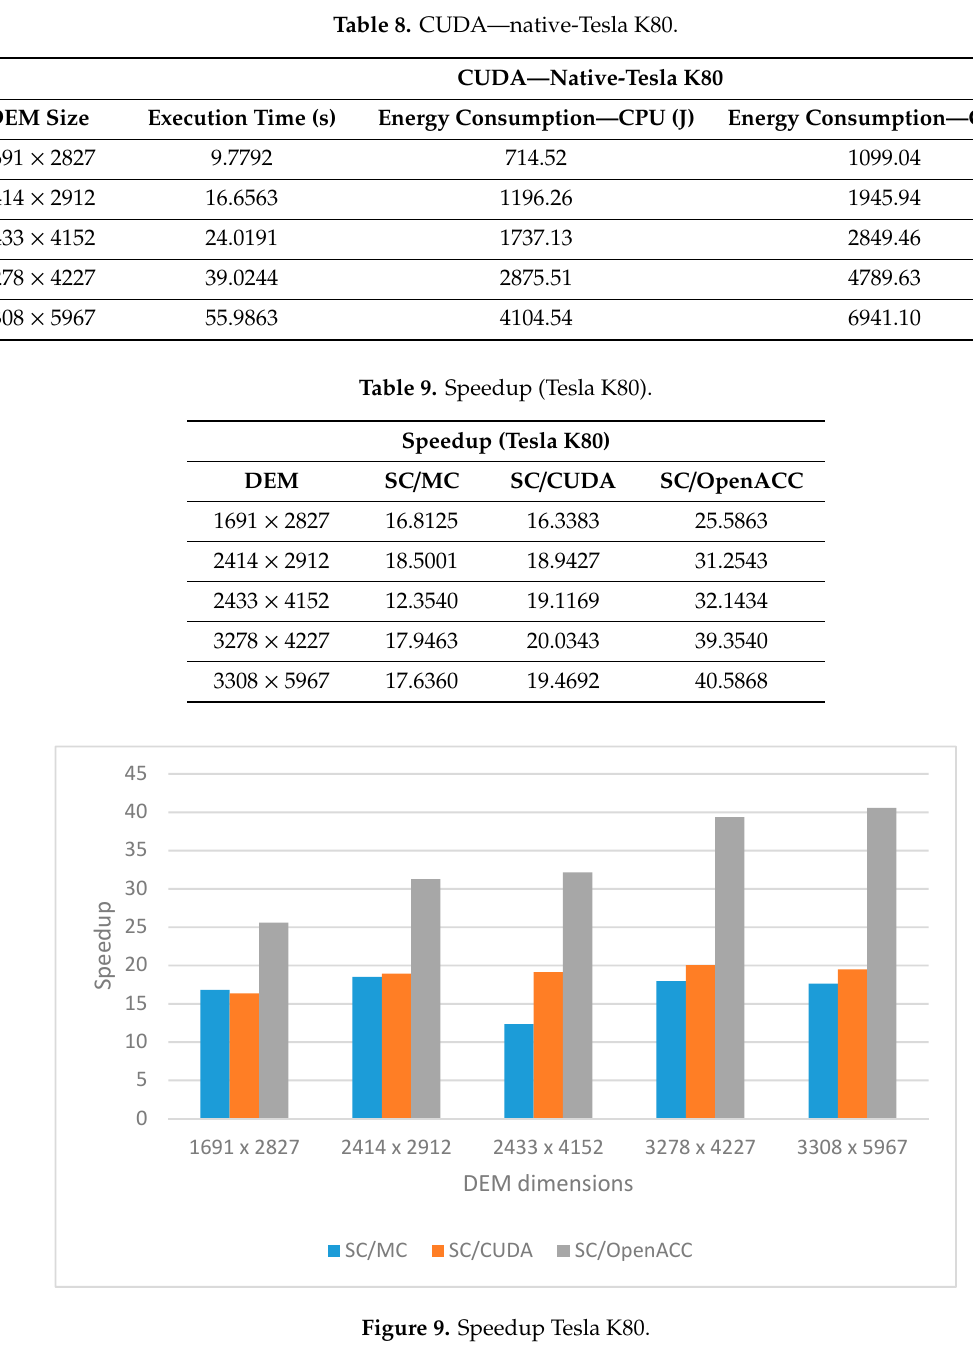
Figure 9. Speedup Tesla K80.